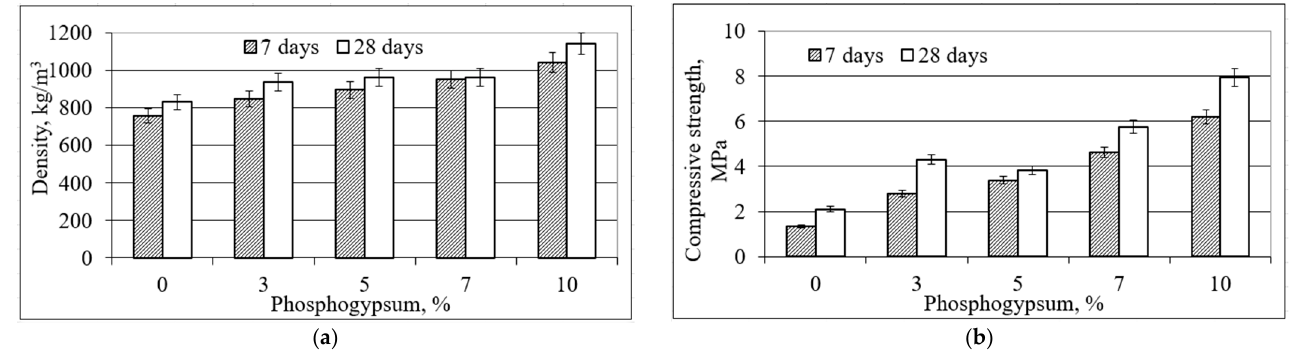
Figure 8. Dependence of density (a) and compressive strength (b) of porous alkali-activated speci-